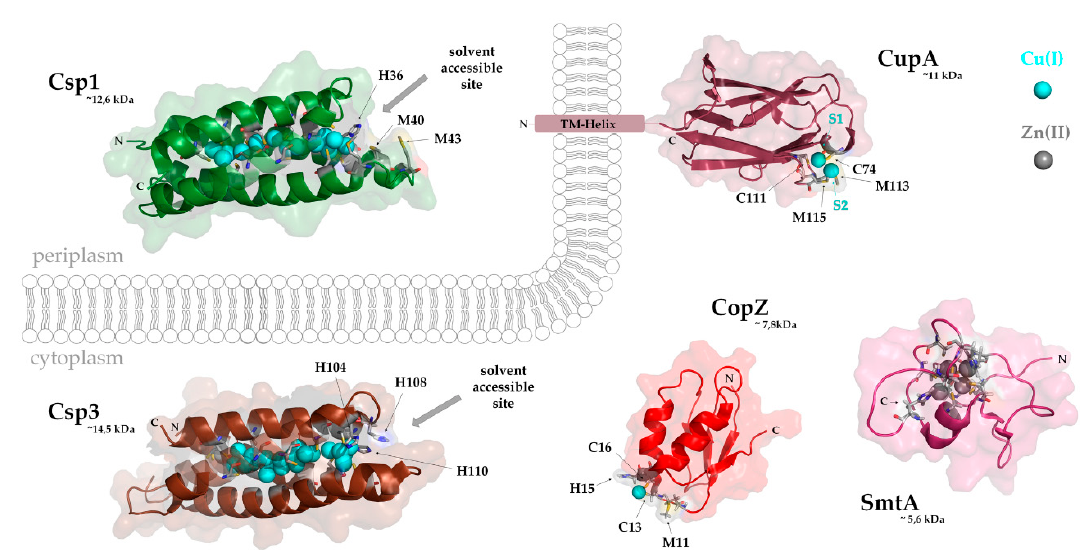
Figure 6. Cu chaperones and Cu storage proteins. Csp1 and Csp3 are Cu-storage proteins, which mainly differ by the presence of a cleavable Tat-signal sequence in Csp1-type proteins, which are translocated into the periplasm. CupA is a membrane-anchored Cu chaperone that has been identified in several Streptococcus species and which contains two Cu binding sites, S1 and S2. It has been suggested that CupA has also cupric reductase activity. CopZ is the prototype of a cytosolic Cu chaperone and homologous are present in all domains of life. CopZ-like proteins contain a single Cu binding site. SmtA is an example of a bacterial metallothionein and was isolated from Synecococcus sp. SmtA binds multiple Cu or Zn ions via cysteine residue and its structure was solved as Zn-SmtA. Structures were retrieved from the protein database (PDB) with the following IDs: 5FJE (Csp1), 5NQO (Csp3), 4f2e (CupA), 1K0V (CopZ), 1JJD (SmtA), and depicted using Pymol. Cu-binding residues are indicated, and Cu ions are shown as cyan spheres. For details, see the text.